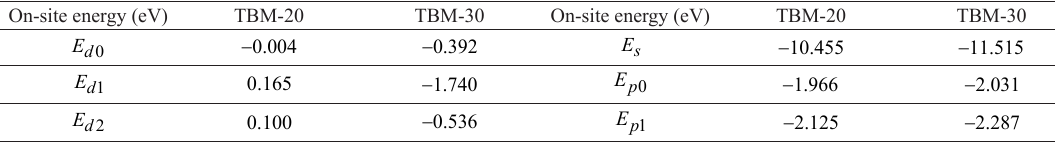
Table 1. Optimized on-site energies of the tight-binding model. The TBM-20 (TBM-30) columns are for the calculation that neglects (considers) overlap integrals between neighbor atoms. On-site energy (eV)